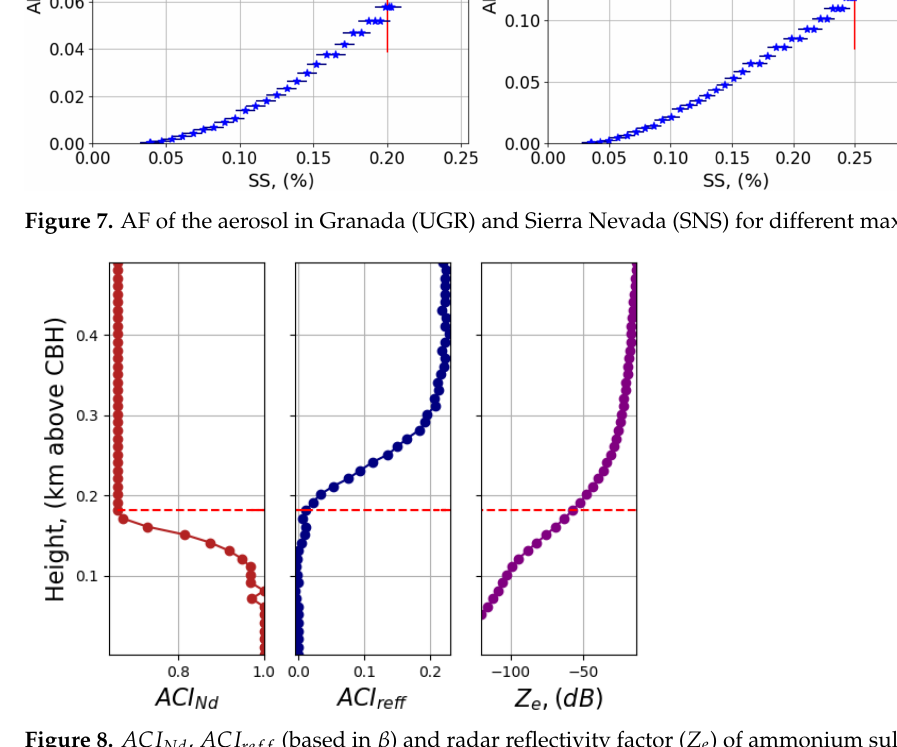
Figure 8. ACI Nd , ACI ref f (based in β ) and radar reflectivity factor ( Z e ) of ammonium sulfate, where the red dashed line marks the height at which the minimum radar sensitivity is reached.